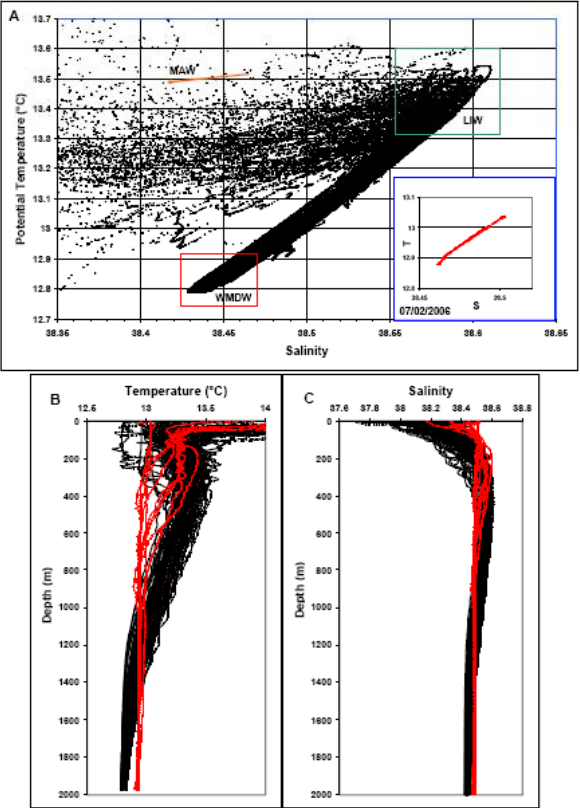
Fig. 2. Hydrological characteristics for the 1995–2007 dataset at DYFAMED. (A) Potential temperature vs. salinity ( T S ) diagram for the whole dataset (1995–2006, last profiles in January 2007). The T S diagram in the inset (right corner) is for the 7 February 2006 profile. (B) Potential temperature profiles (2006 profiles are in red). (C) Salinity profiles (2006 profiles in